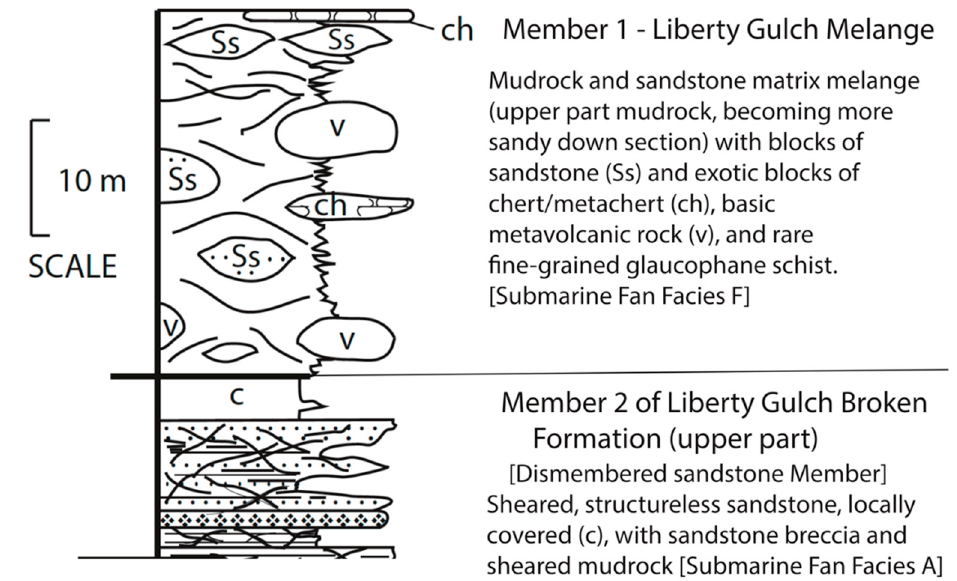
Figure 3. Section of Liberty Gulch Mélange (member) and underlying Dismembered Formation Member 2 of Liberty Gulch Broken Formation. Mélange (submarine fan facies F) conformably overlies Dismembered Sandstone Member 2, a sheared submarine fan facies A unit with local interbedded sheared mudrock (modified from [32]).